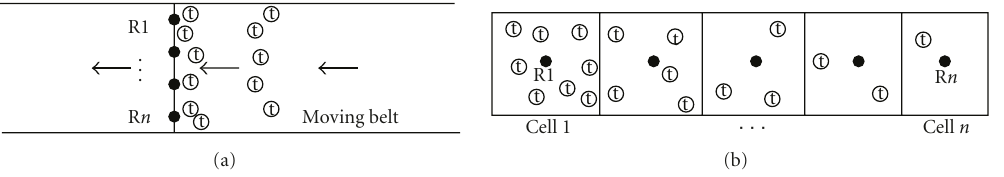
Figure 12: Simulation Scenarios. (a) Readers operating across the width of a moving belt containing tags. The readers are spaced equally apart with the width of belt deciding overlap between readers. The tags are uniformly distributed across the width of the belt. (b) Multiple cells with a reader assigned to the center of each cell. Each group of tags in a cell could be visualized as those on a mobile object, say a box or truck, that is replaced by another and so on. The number of tags in a cell has a geometric distribution starting from Cell 1. The tags in each cell are uniformly distributed.